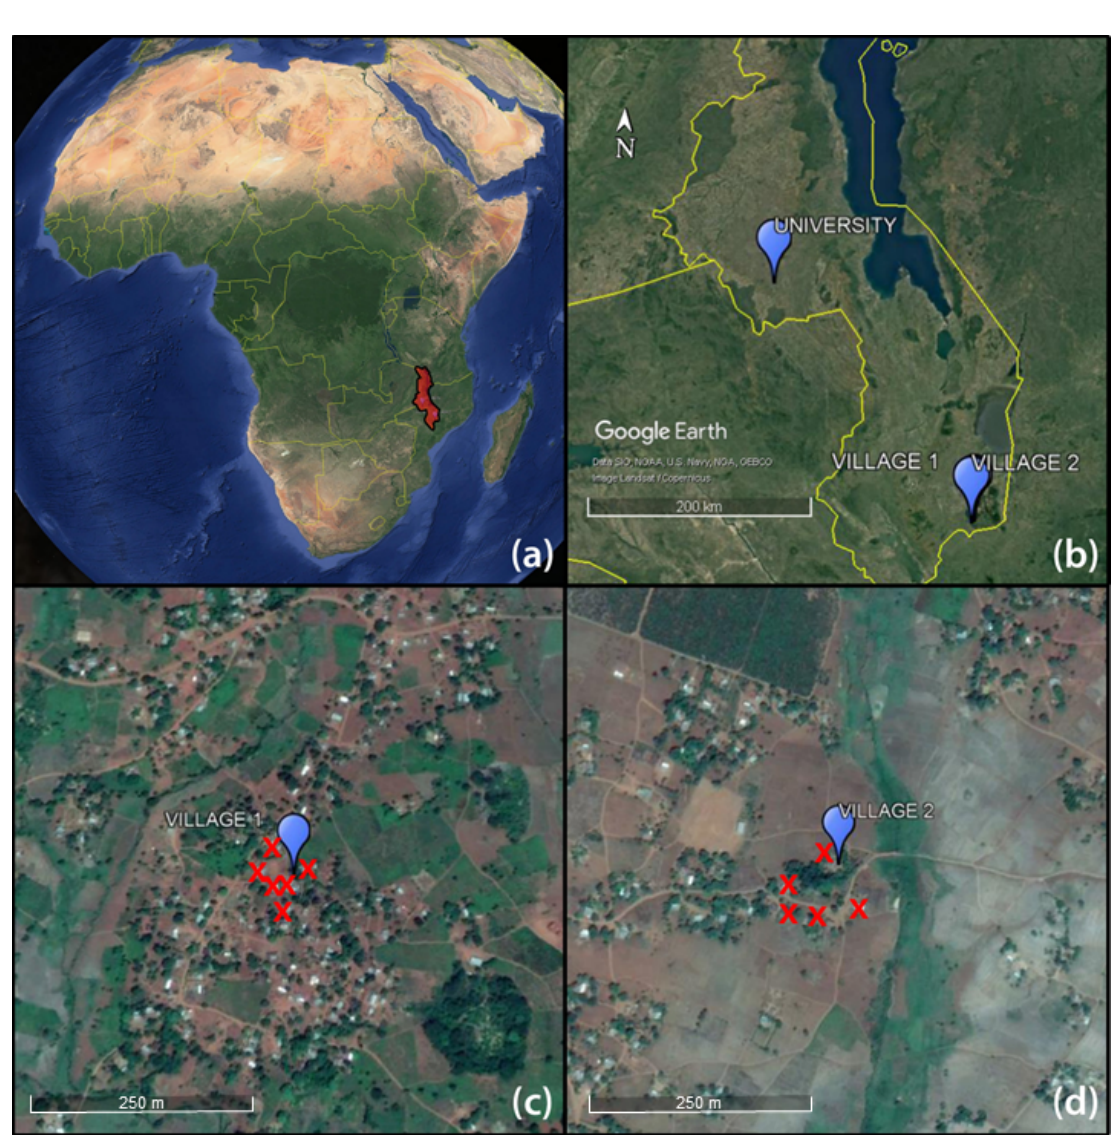
Figure 1. (a) Satellite map of Malawi in southeastern Africa, (b) three ARISense monitoring sites in Malawi, (c) satellite map of Village 1, and (d) satellite map of Village 2. Blue markers indicate ARISense monitoring sites. Red crosses indicate the location of known biomass cookstoves within 50m of the monitoring site. The image source is Google Earth Pro Version 7.3.4.8248. University, Village 1, and